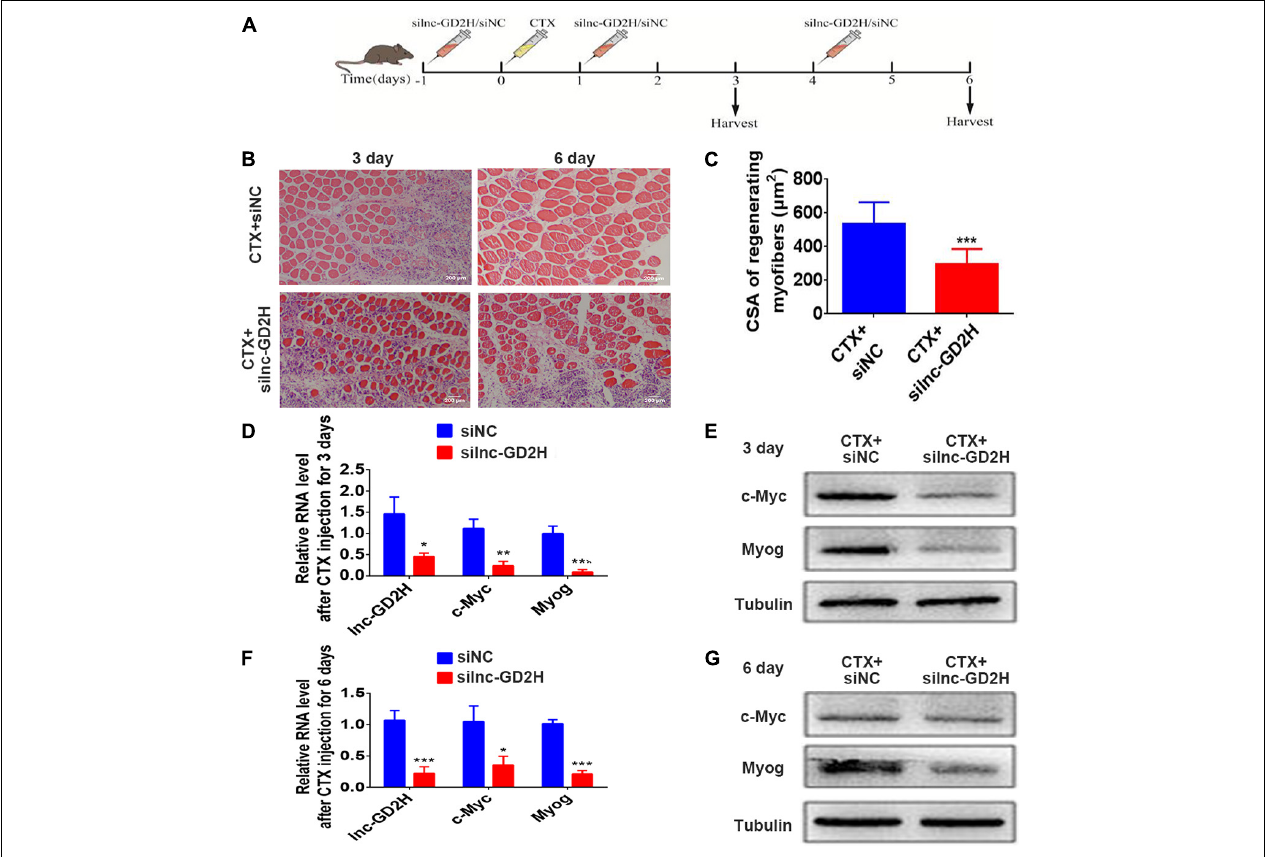
FIGURE 8 | Lnc-GD2H promoted the repair of muscle injury. (A) Protocol for siNC or silnc-GD2H injection into CTX-injured muscles. (B) Representative H&E-stained images of the tibialis anterior muscle on days 3 and 6 after CTX injury. (C) The average fiber CSA on day 6 after CTX injury. (D) Relative expression level of lnc-GD2H on day 3 after CTX injection based on qPCR; knockdown of lnc-GD2H reduced the mRNA (D) and protein (E) levels of c-Myc and Myog on day 3 after CTX injection. (F) Relative lnc-GD2H expression level on day 6 after CTX injection; knockdown of lnc-GD2H reduced the mRNA (F) and protein (G) levels of c-Myc and Myog on day 6 after CTX injection. Animal study, n = 6; cell experiment, n = 3. * P < 0.05, ** P < 0.01, and *** P <